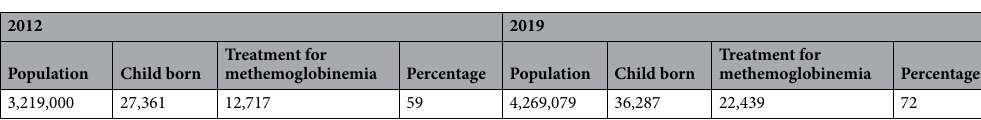
Table 3. Patients’ treatment data from January to April in 2012 and 2019. Source: Health Department of Khyber